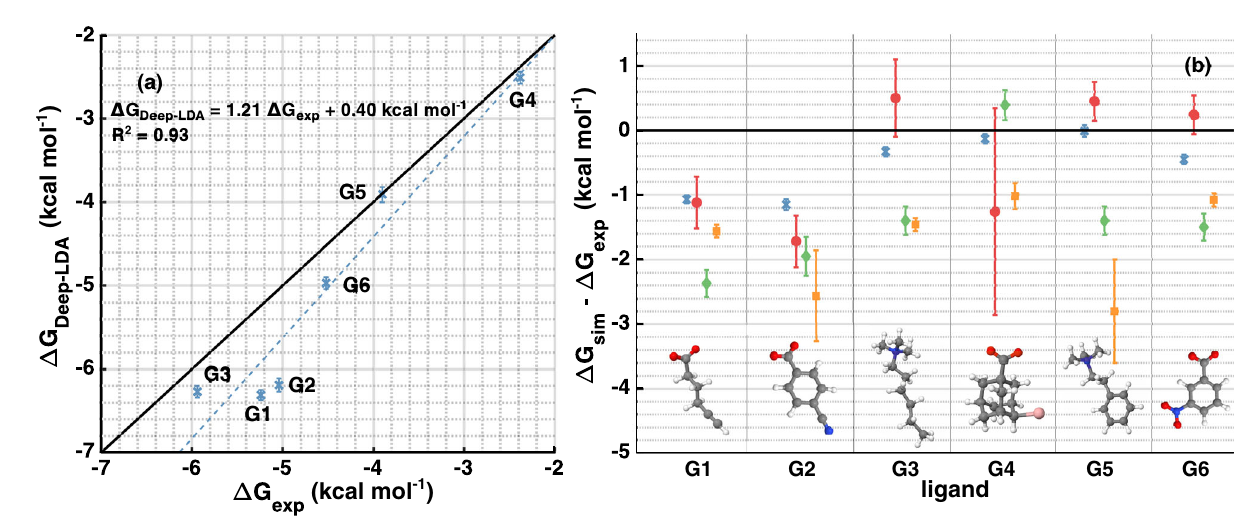
Fig. 4 Comparison of the binding free energies with experiments and other calculations. In a , we plot the value of Δ G obtained from the Deep-LDA simulations (in blue crosses) for every ligand versus the experimental values and show the corresponding linear fi t. In b , we report their difference with the experimental values and compare them with other computational results performed using the same simulation setup. Results from ref. 36 are indicated with red circles, from ref. 34 in green diamonds, and from ref. 35 in yellow